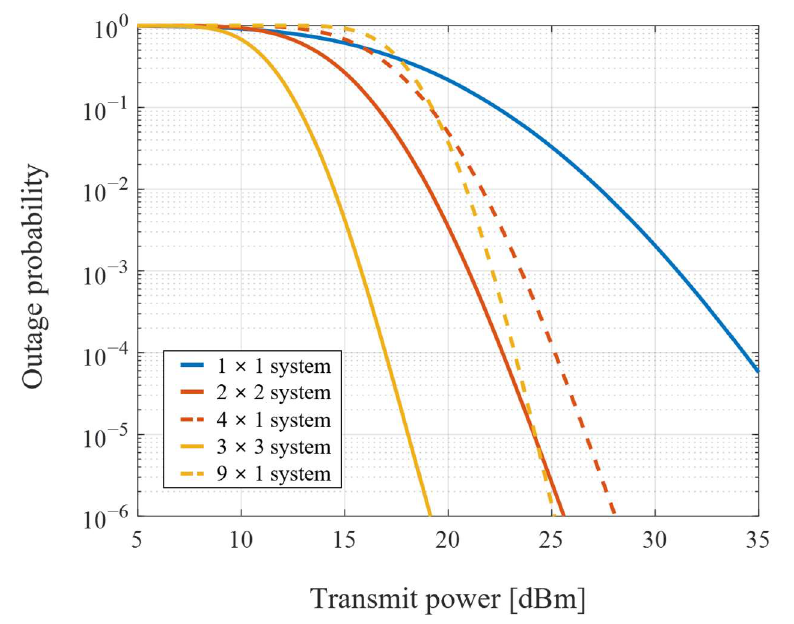
Figure 6. Overall outage performance of the total four and nine diversity channels.